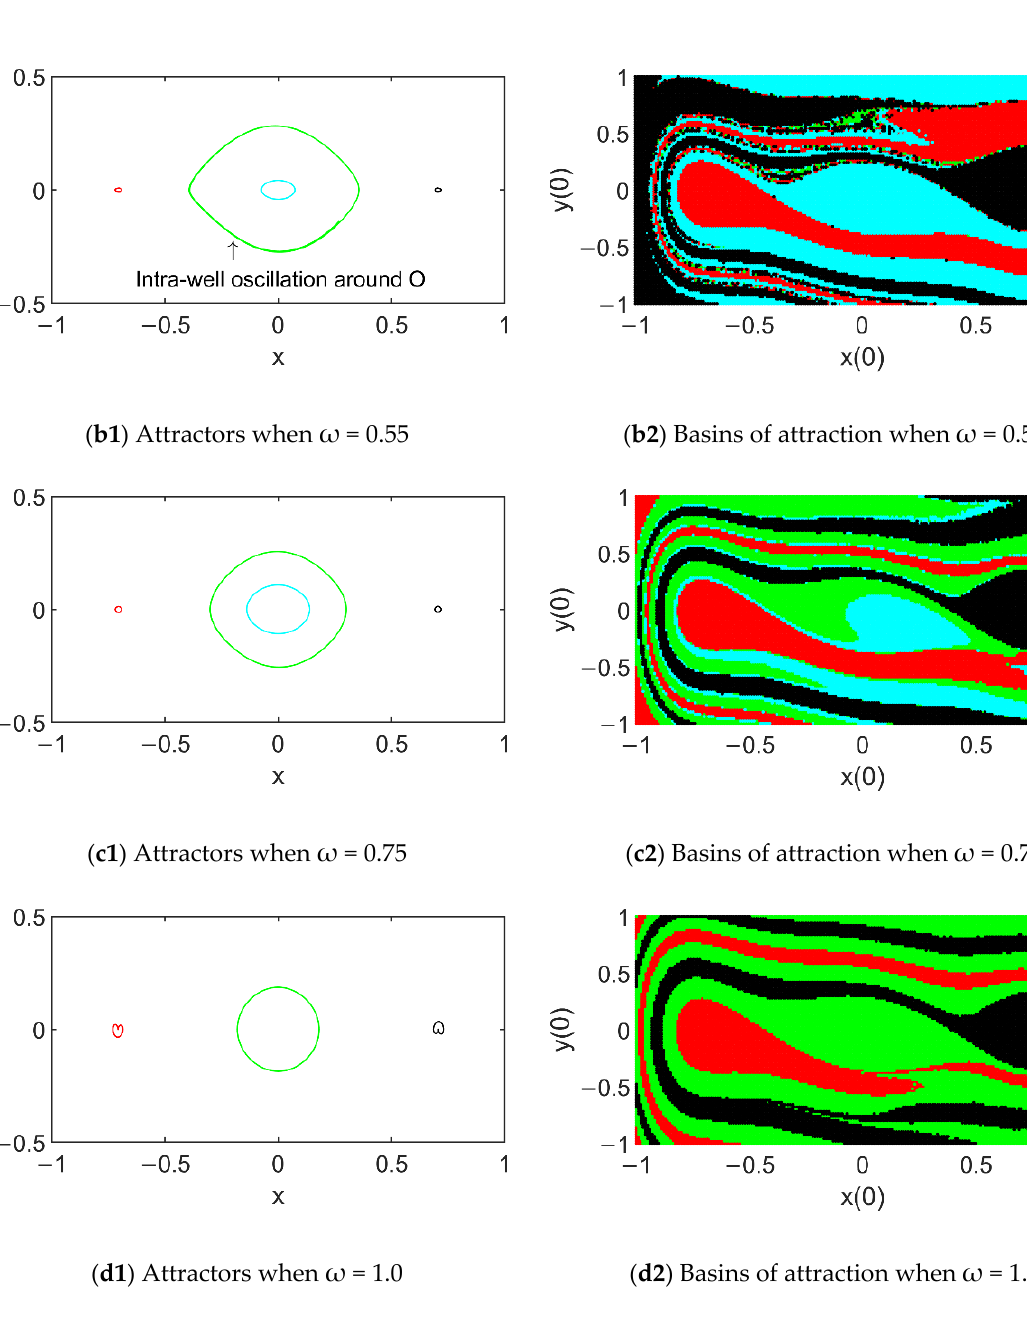
Figure 4. Evolution of attractors and their basins of attraction with the increase of ω for f 0 = 0.05.